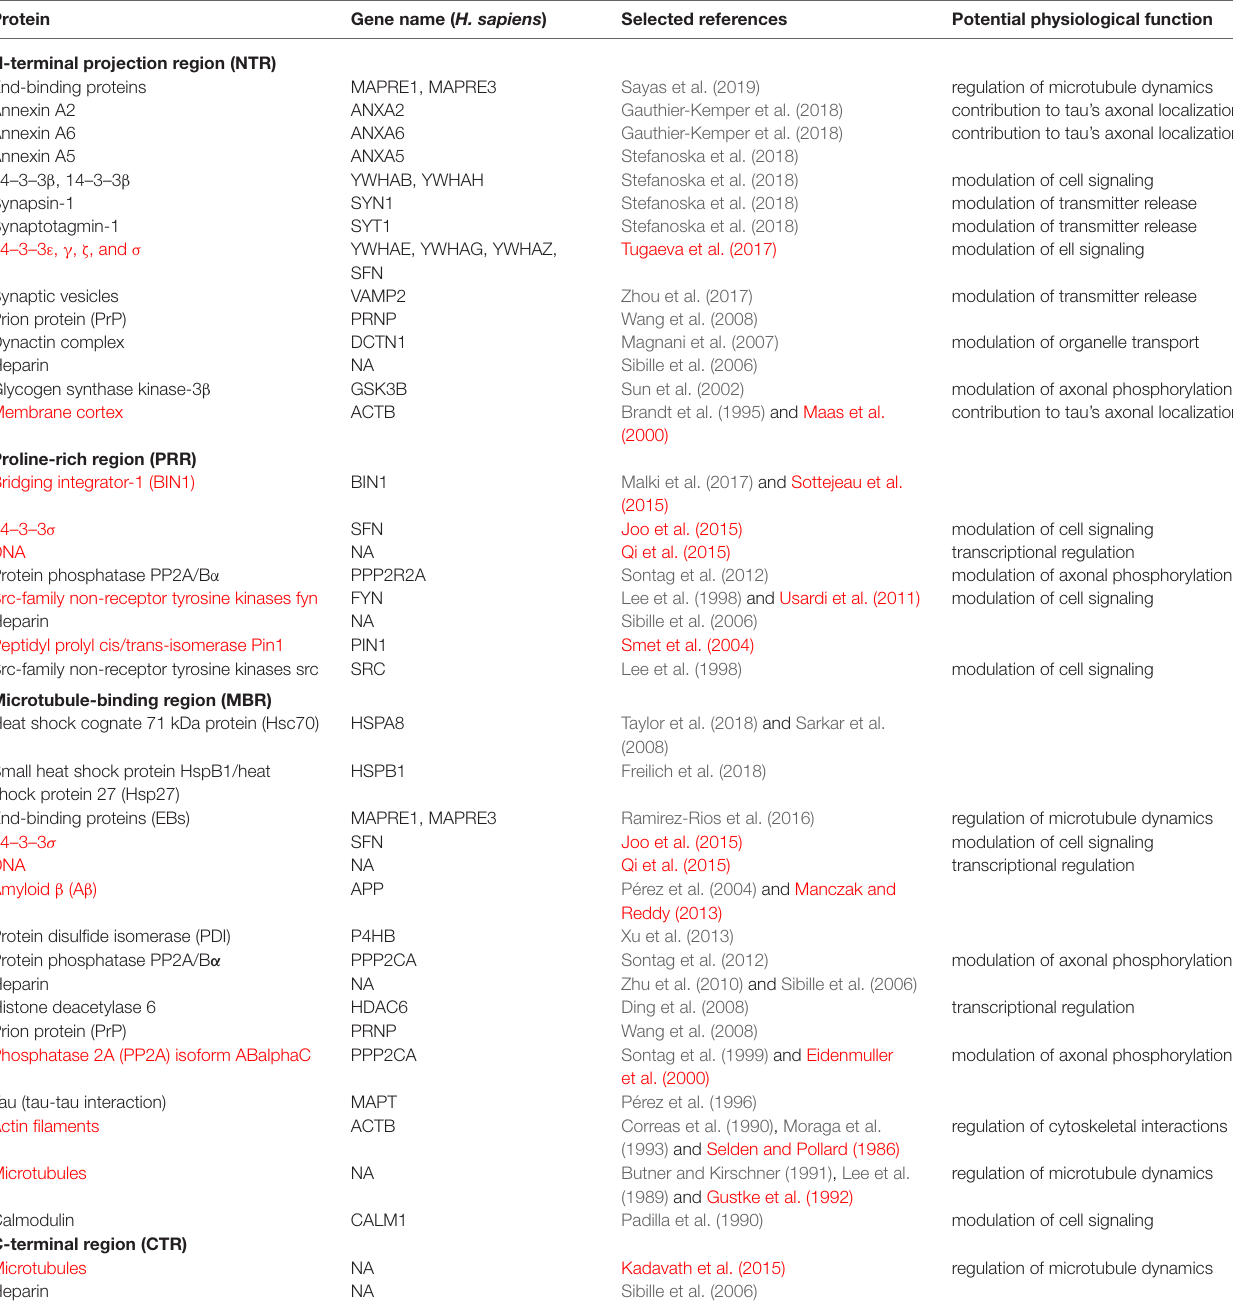
TABLE 1.1 | Tau binding partners, whose interactions have been mapped to specific regions of tau